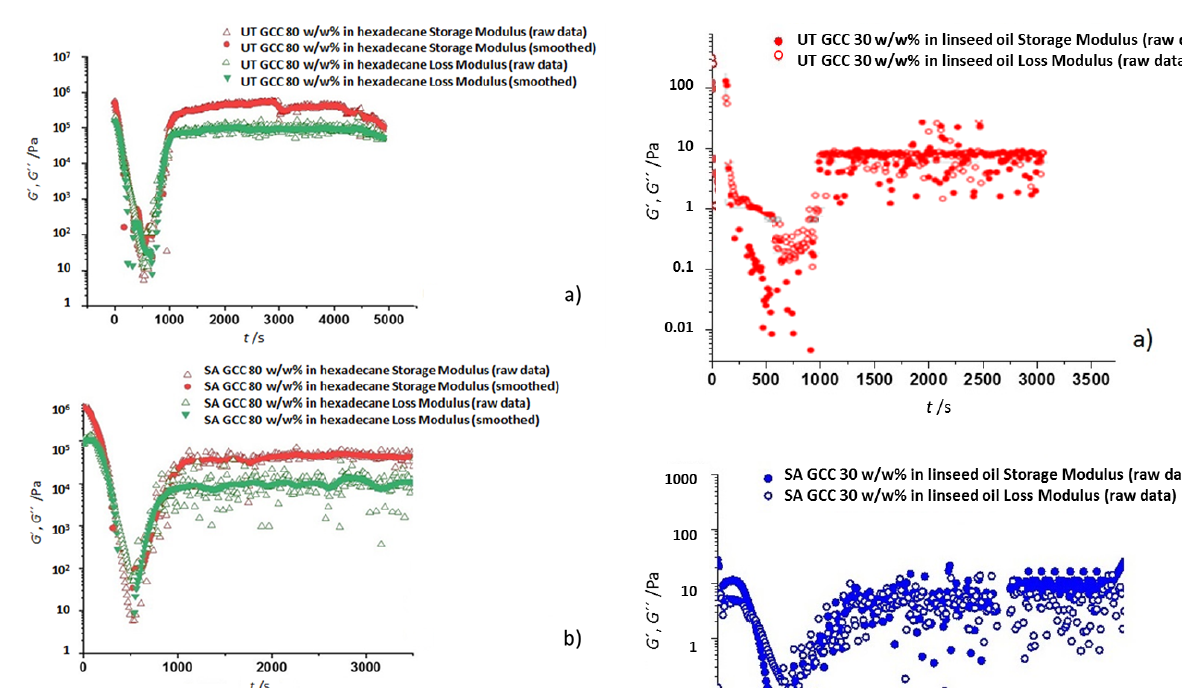
erates are not excluded from the boundary, the coupling is complete into the bulk and the data follow the upper stress moduli curve. However, if the particles, mainly ag- glomerates, are excluded from the boundary only the re- duced solids layer contacting the boundary yields, record- ing a much lower decoupled stress